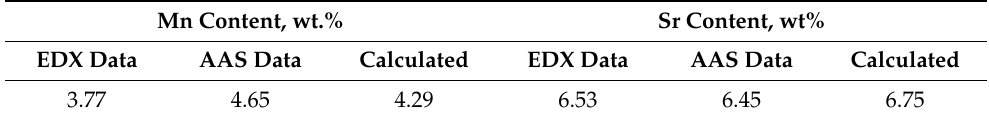
Table 2. Mn and Sr content in Ca 2.5 Mn 0.25 Sr 0.25 (PO 4 ) 2 powder. Mn Content, wt.%